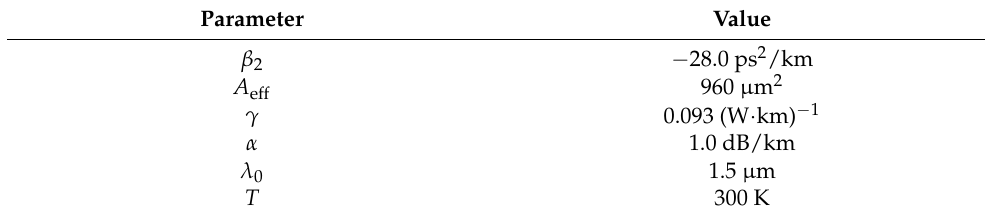
Table 1. Parameters used in the